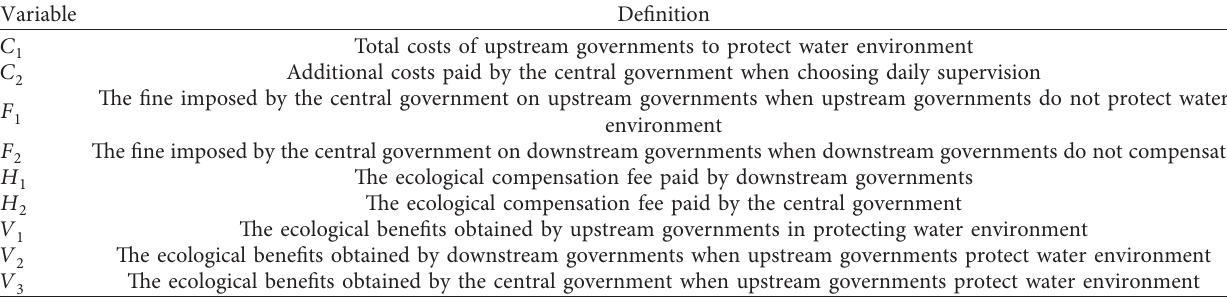
Table 1: The variables in the game model.